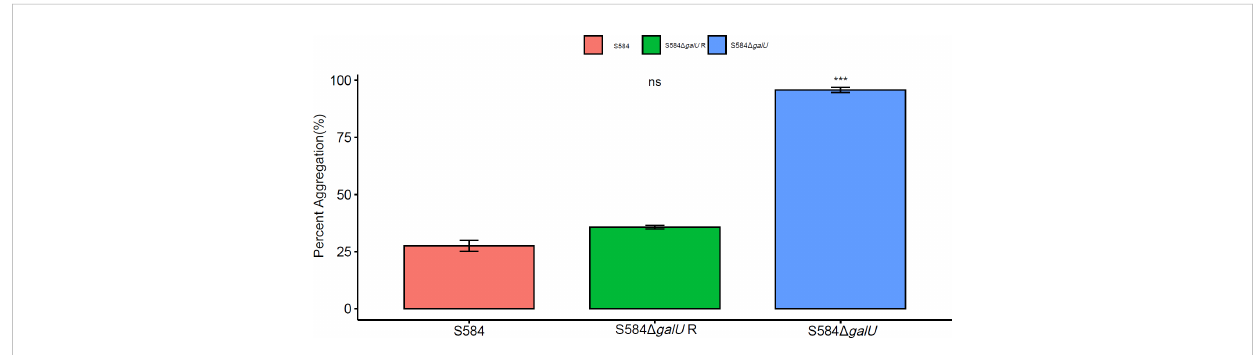
FIGURE 2 Self-agglutination properties. Different colors represent different strains (red = S584, green = S584 D galU R, and blue = S584 D galU ). The vertical coordinate of the graph shows the self-agglutination rate for each strain. Ns means no signi fi cant difference. *** means very signi fi cant difference.